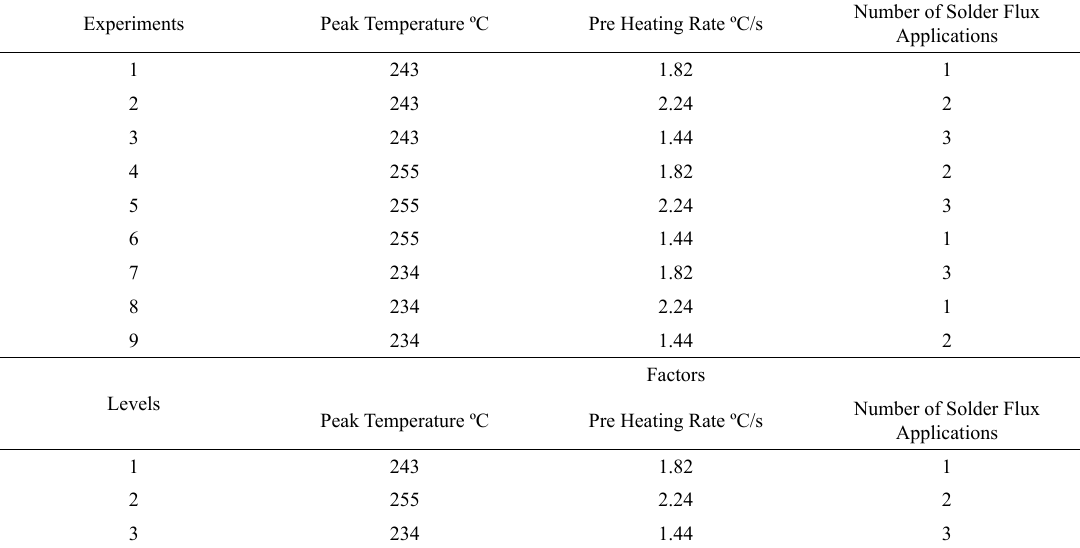
Table 1. Orthogonal array with nine experiments and levels of each